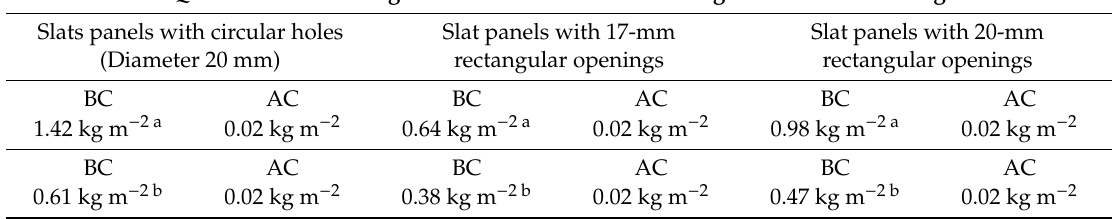
Table 1. Quantitative cleaning performance: Removed excrement quantities per m² and type of slatted floor, differentiated according to the cleaning runs in the morning or in the afternoon. Quantitative Cleaning Performance after the Cleaning Runs in the Morning Slats panels with circular holes (Diameter 20 mm)